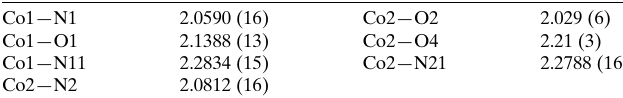
Table 1 Selected bond lengths (A˚ ) for 1 .